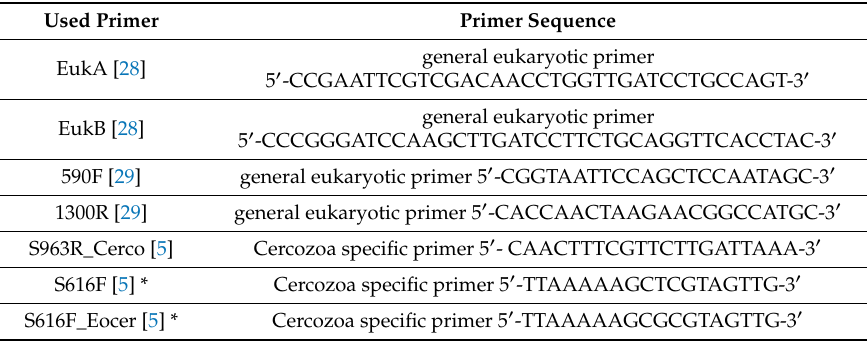
Table 2. Corresponding primers for SSU rDNA